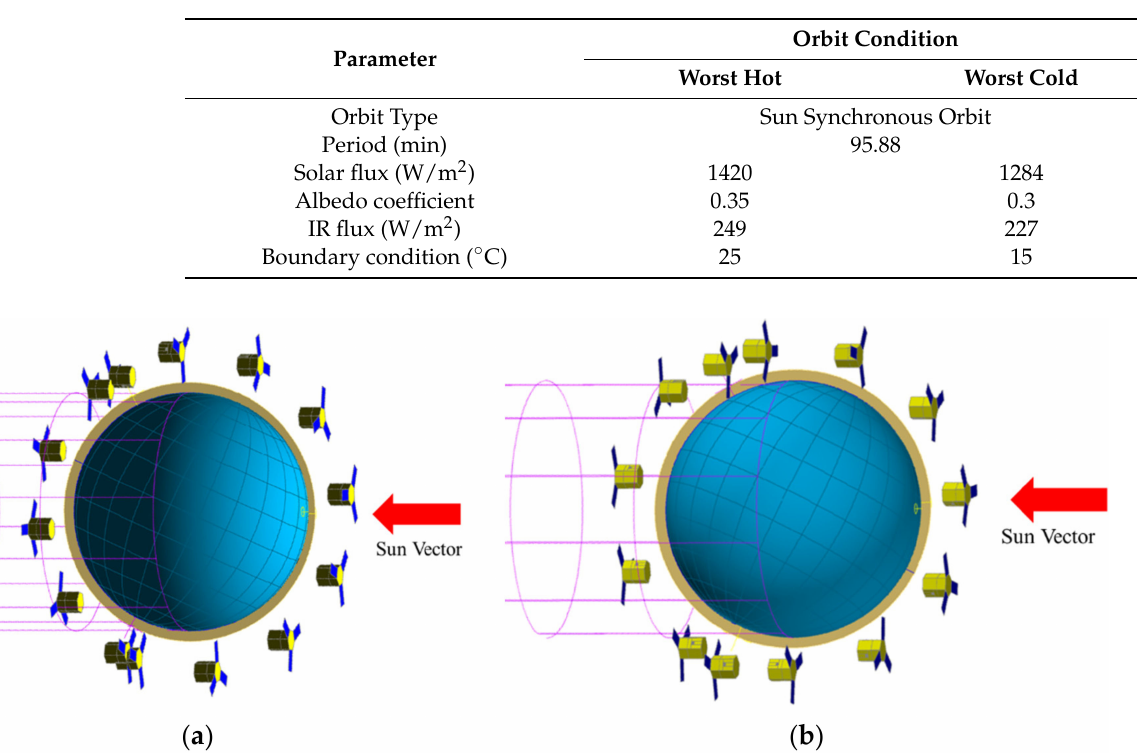
Table 5. Orbit parameter of BB.